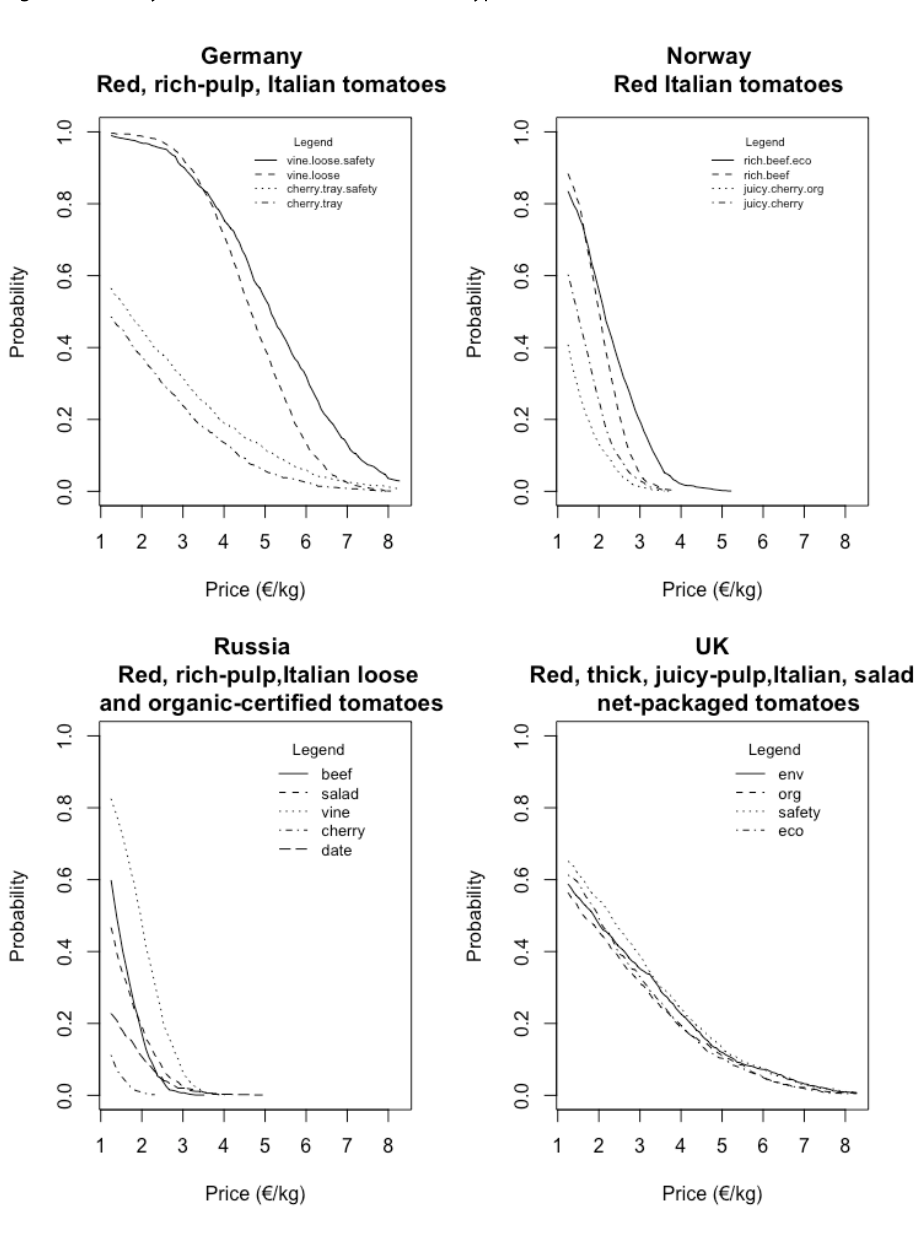
Figure 3. Country-level demand functions for some types of